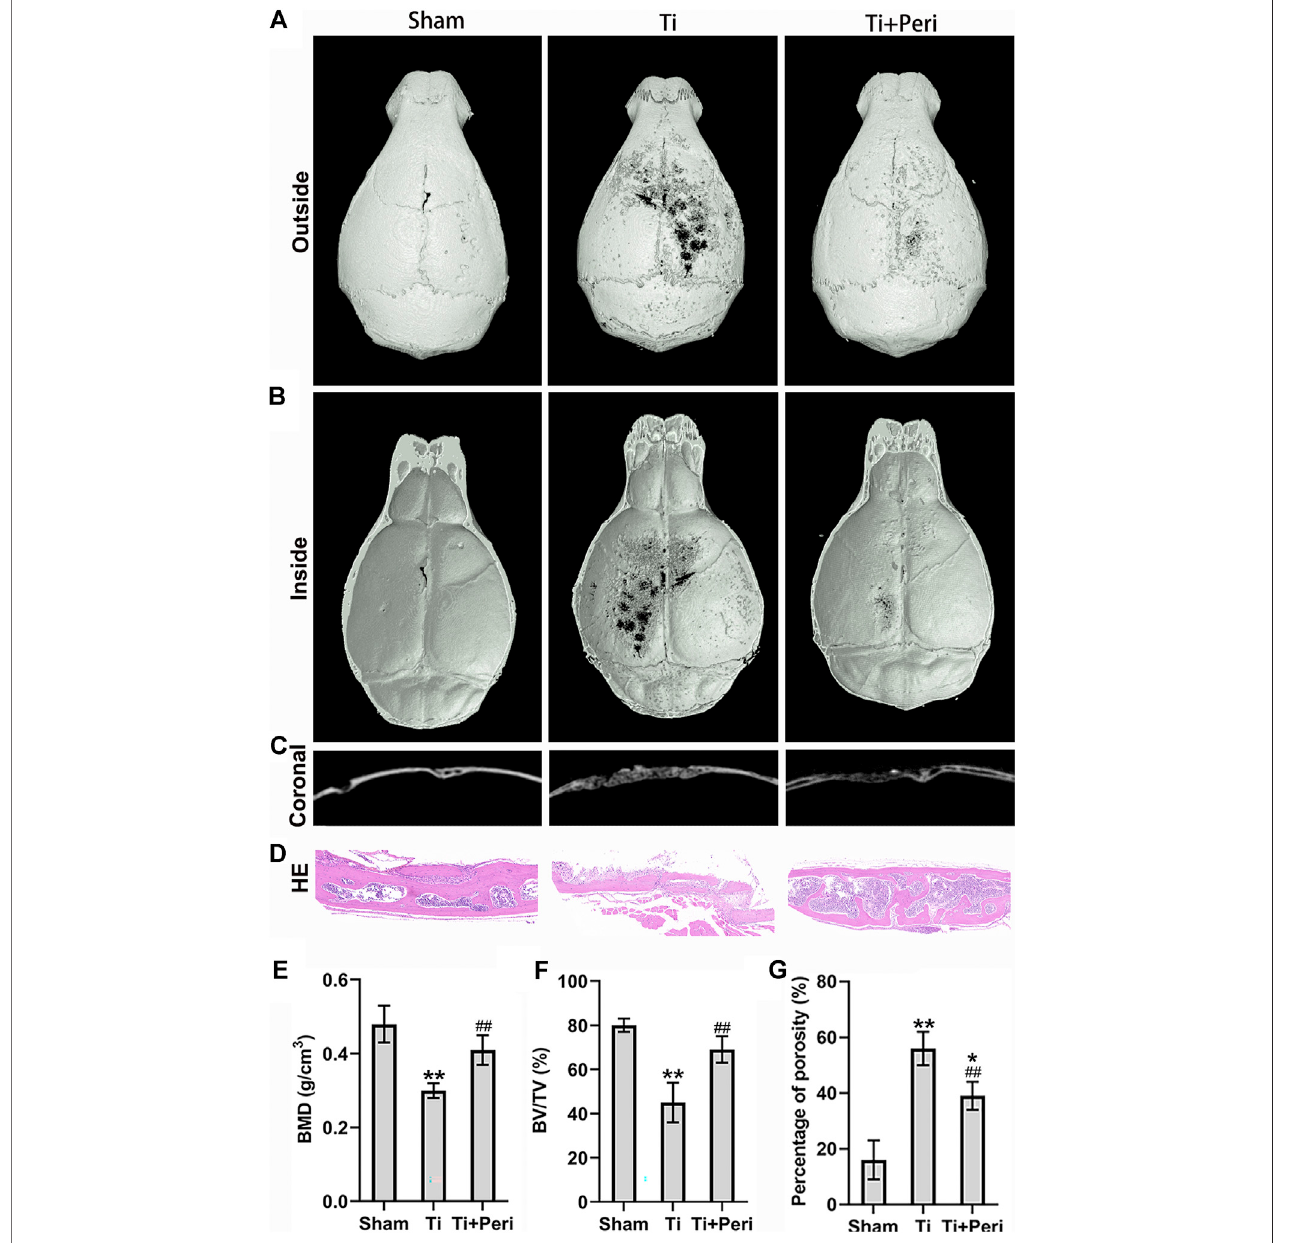
FIGURE3| InhibitionofACEmitigatedTi-particle-inducedosteolysisinamurinecalvarialmodel.Dataarerepresentativeimagesorexpressed asthemean ± SDof each group from three separate experiments ( n (cid:1) 3 per group). (A – C) Three-dimensional reconstructed images of representative micro-CT from each group. (D) Representative H and E staining images (magni fi cation × 400). (E) Quantitative analyses of BMD (g/cm 2 ). (F) Quantitative analyses of BV/TV (%). (G) The percentage of total porosity (%). * p < 0.05 vs. the sham group; ** p < 0.01 vs. the sham group; ## p < 0.01 vs. the Ti group.